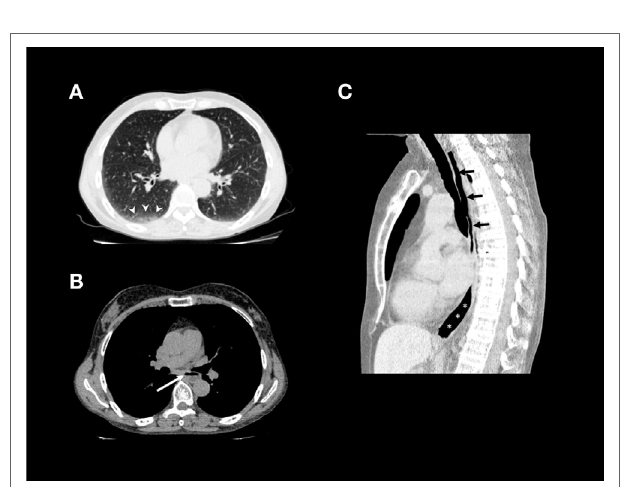
FIgURe 2 | (a) Non-contrast chest CT (lung window) shows interlobular septal thickening and ground-glass opacities in the immediate subpleural lung with peripheral and lower lobe predominance, especially on the right side (arrowheads). (B) Non-contrast chest CT (mediastinal window): air–fluid level due to stasis in thoracic esophagus (arrow). (C) Non-constrast chest CT, sagittal reformation: air-filled hypotonic upper (arrows) and lower (asterisks) thoracic